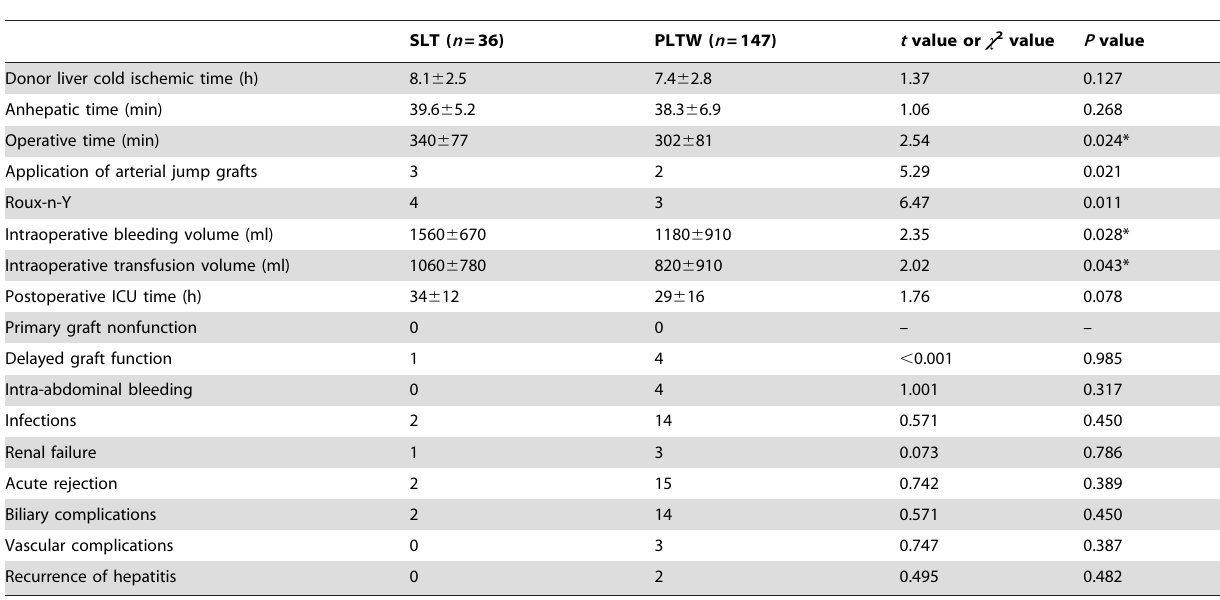
Table 2. Operative parameters and postoperative complications.